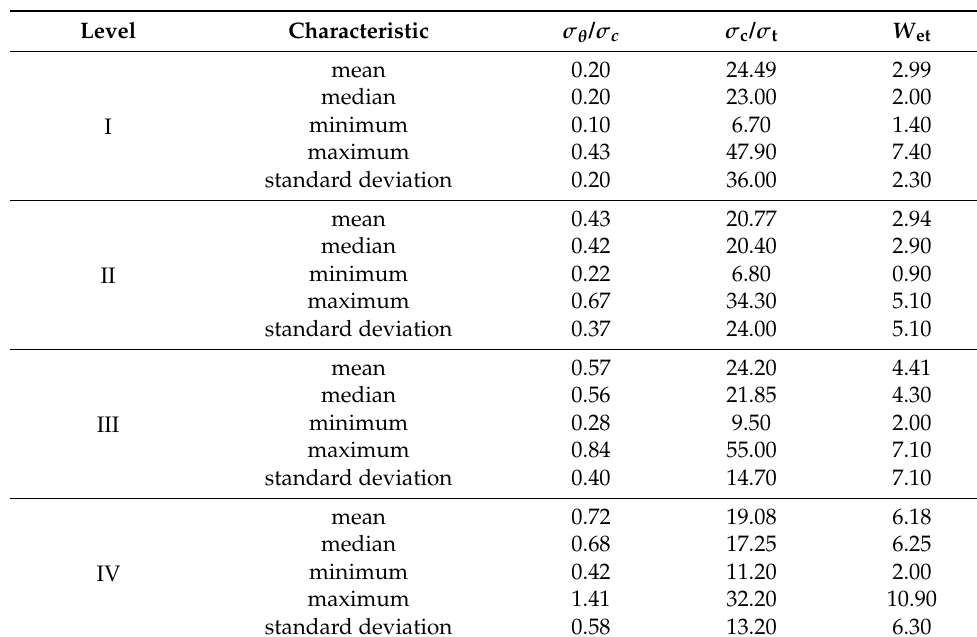
Figure 2. Box plot of prediction indexes: ( a ) σ θ / σ c ; ( b ) σ c / σ t ; ( c ) W et . Table 1. Statistical parameters of rockburst prediction